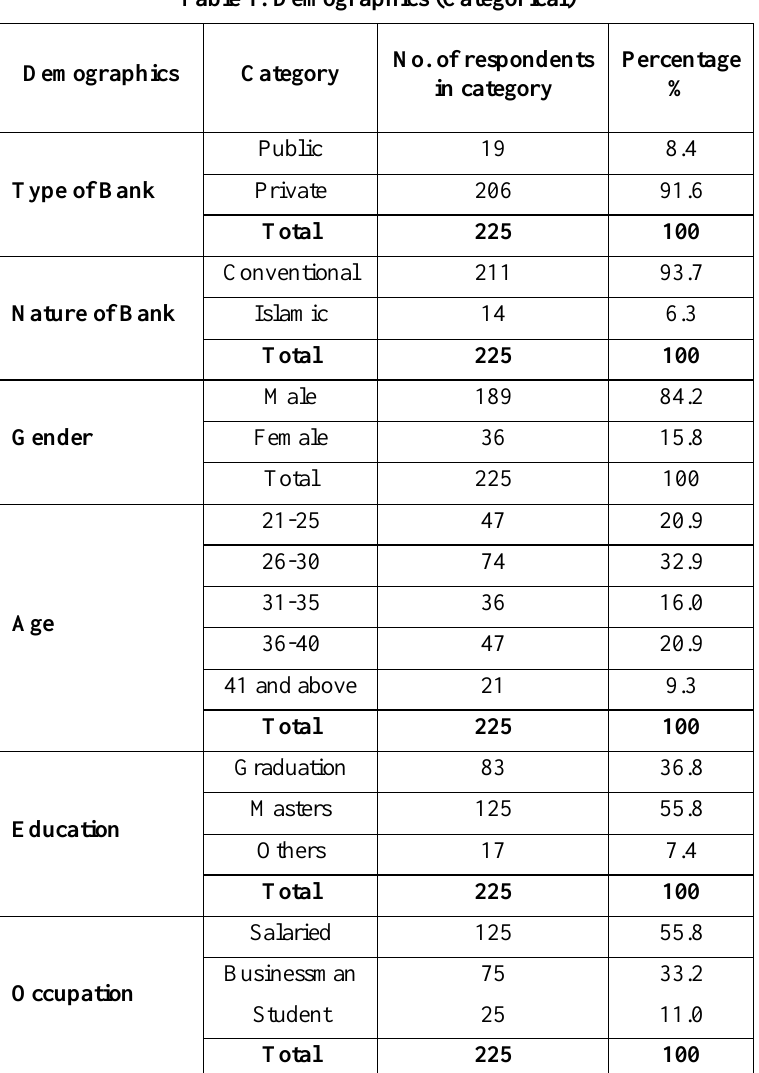
Table 1: Demographics